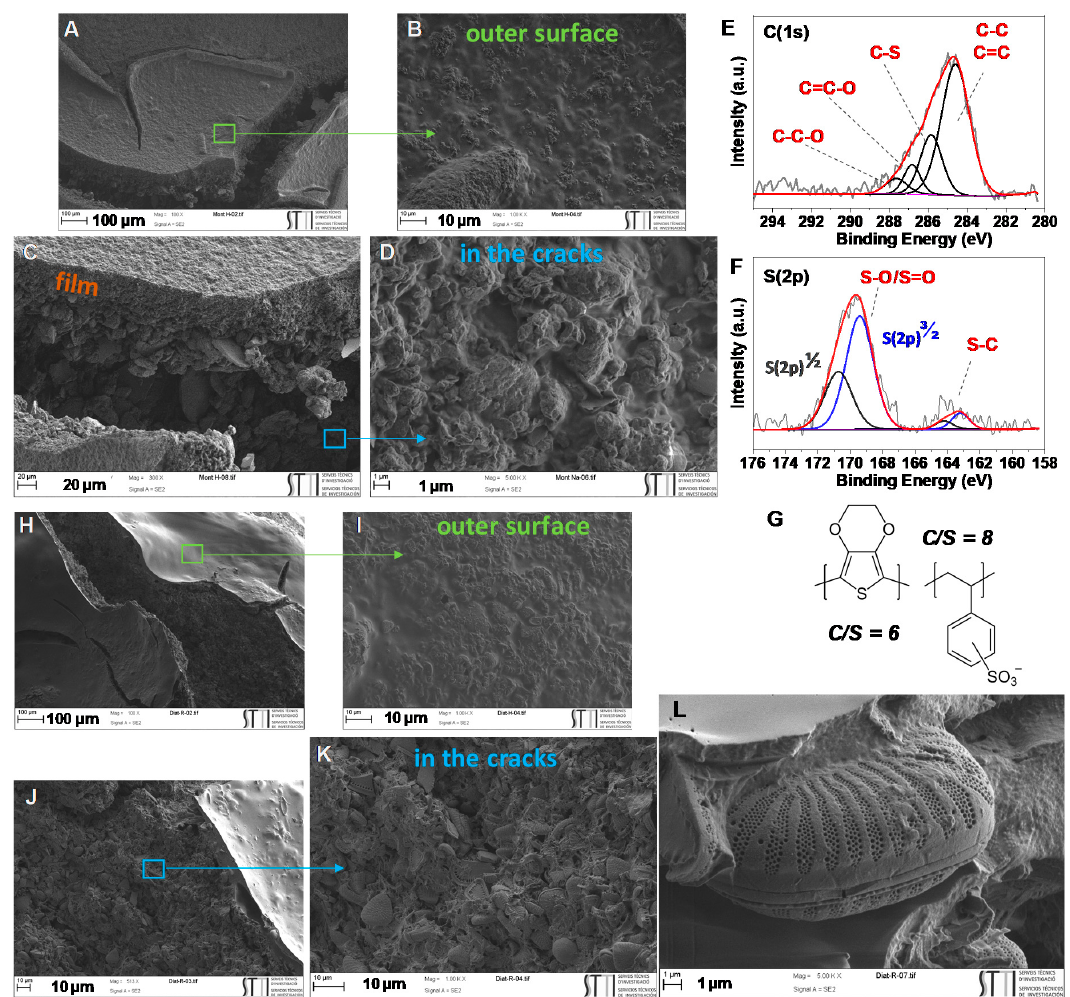
Figure 5. FE-SEM images at distinct magnifications of GC-supported Mont/PEDOT-PSS ( A–D ) and Diat/PEDOT-PSS ( H–L ); and C(1s) ( E ) and S(2p) ( F ) XPS spectra of GC-supported Mont/PEDOT-PSS